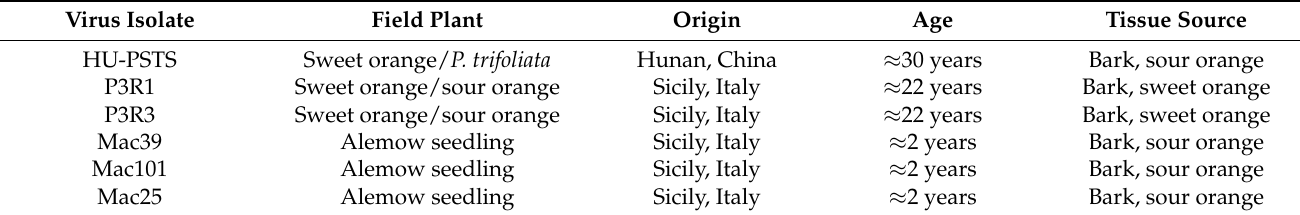
Table 2. Virus isolate and source plants used to assess the virome by using high-throughput